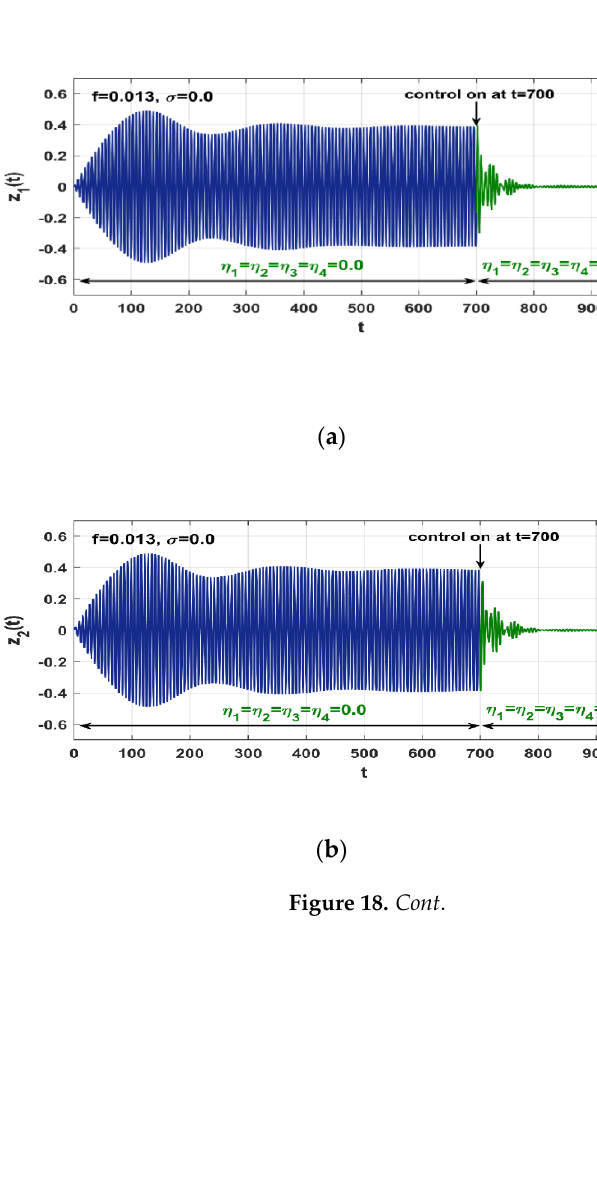
Figure 17. Vibration amplitudes and phase angles of the twelve-poles rotor in the case of both the 𝑃𝐷 -control algorithm only and the 𝑃𝐷 + 𝐼𝑅𝐶 + 𝑃𝑃𝐹 -control algorithm when 𝑓 = 0.013 : ( a , b ) vibra- tion amplitudes ( 𝑎 (cid:2869) , 𝑎 (cid:2870) ) of the rotor, and ( c , d ) vibration amplitudes ( 𝑏 (cid:2869) , 𝑏 (cid:2870) ) of the 𝑃𝑃𝐹 controller, ( e ) phase angles ( 𝜙 (cid:2869) , 𝜙 (cid:2870) ) when 𝜂 (cid:2869) = 𝜂 (cid:2870) = 𝜂 (cid:2871) = 𝜂 (cid:2872) = 0.0 , and ( f ) phase angles ( 𝜙 (cid:2869) ,𝜙 (cid:2870) ) when 𝜂 (cid:2869) = 𝜂 (cid:2871) = 𝜂 (cid:2870) = 𝜂 (cid:2872) = 0.2 .